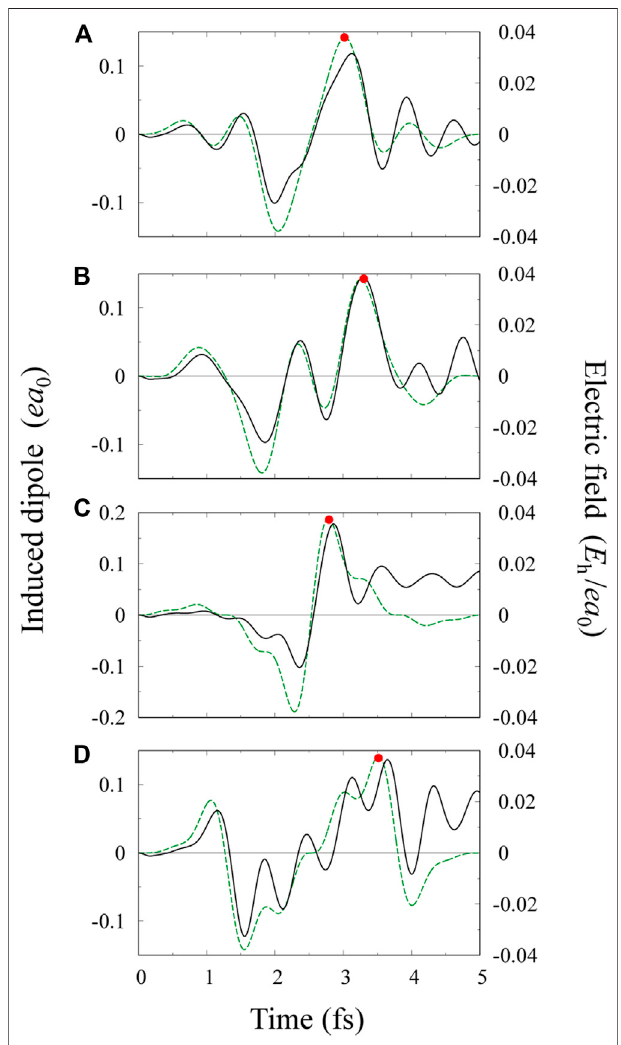
FIGURE 3 | Electric fi eld pro fi les for multi-color pulses (green broken lines): (A, B) three-color pulses with relative intensities a 2 (cid:2) 2 / 3 and a 3 (cid:2) 1 / 3; (C, D) four-color pulses with relative intensities a 2 (cid:2) 1 / 2, a 3 (cid:2) 1 / 3, and a 4 (cid:2) 1 / 4. The relative pahses and the intensity parameter F T in Eq. 18 are given as follows: (A) φ 1 (cid:2) φ 2 (cid:2) − π / 2, φ 3 (cid:2) π / 2, and E T (cid:2) 0 . 0541 E h /( ea 0 ); (B) φ 1 (cid:2) − π / 2, φ 2 (cid:2) φ 3 (cid:2) π / 2, and F T (cid:2) 0.0611 E h /( ea 0 ); (C) φ 1 (cid:2) φ 2 (cid:2) φ 3 (cid:2) φ (cid:2) − π / 2 and F (cid:2) 0.0528 E φ (cid:2) φ (cid:2) − π / 2, φ (cid:2) φ (cid:2) π / 2, and T h /( ea 0 ); (D) 4 1 3 2 4 F T (cid:2) 0.0778 E h /( ea 0 ). The induced dipole mements d 5 σ ( t ) of the 5 σ natural orbital for each pulse, denoted by a black solid line, is obtained by TD-